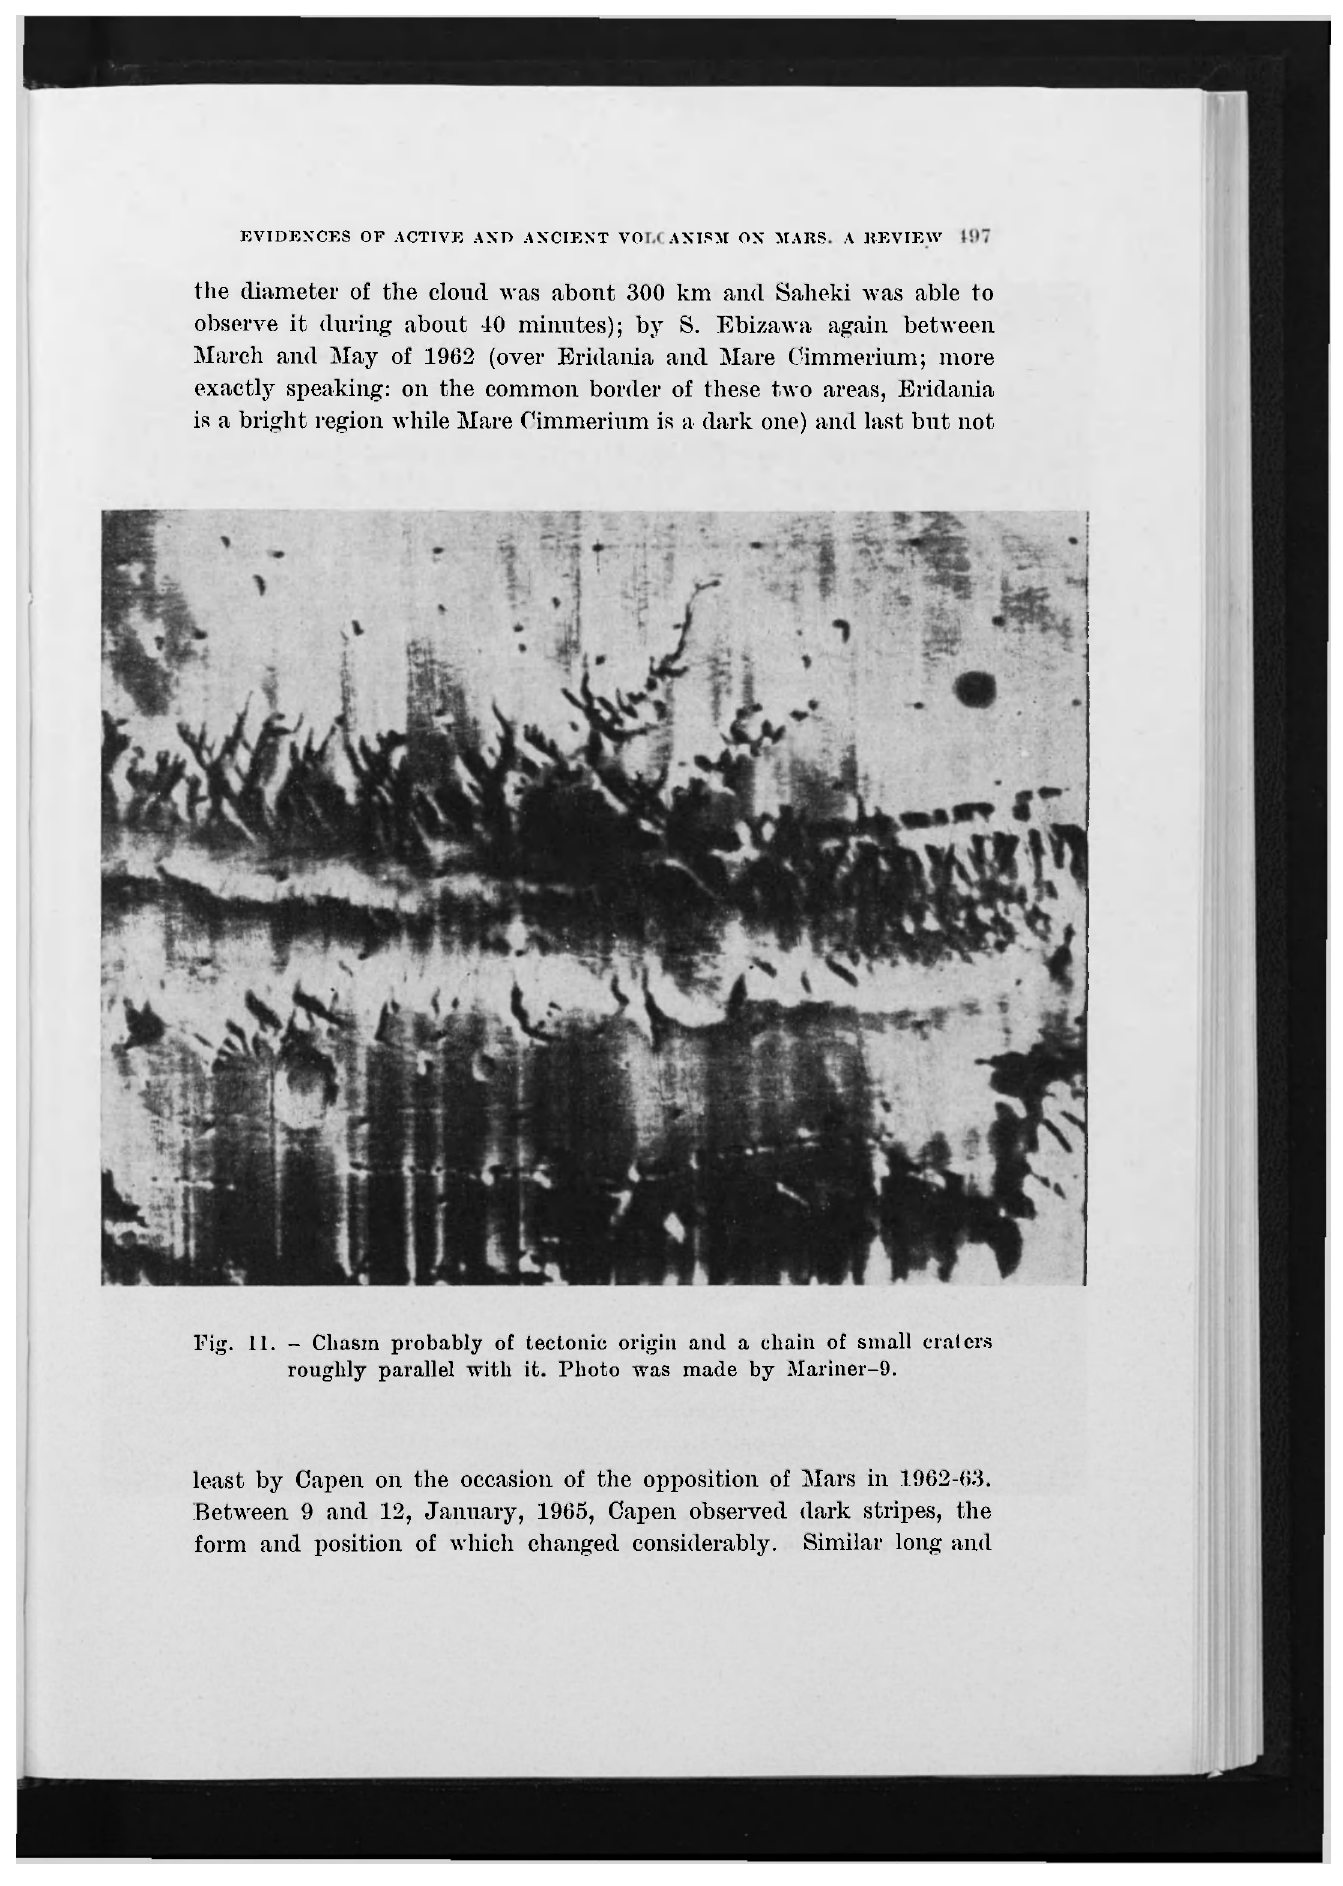
Fig. 11. - Cliasin probably of tectonic origin and a chain of small craters roughly parallel with it. Photo was made by